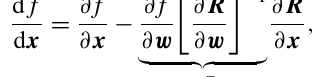
is set to 10 − 7 . These convergence thresholds are not to be confused with the optimality tolerance, which we set to 10 − 4